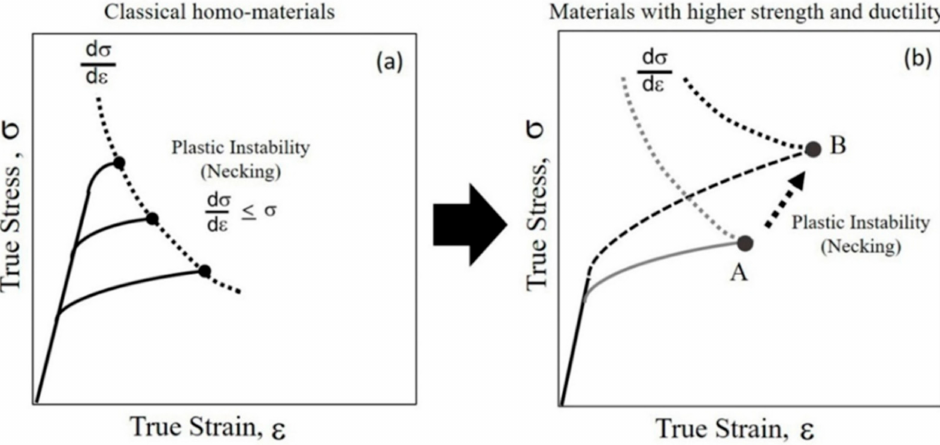
Figure 6. Schematics of true stress–true strain curves for ( a ) conventional homogenous materials and ( b ) high strength and high ductility materials